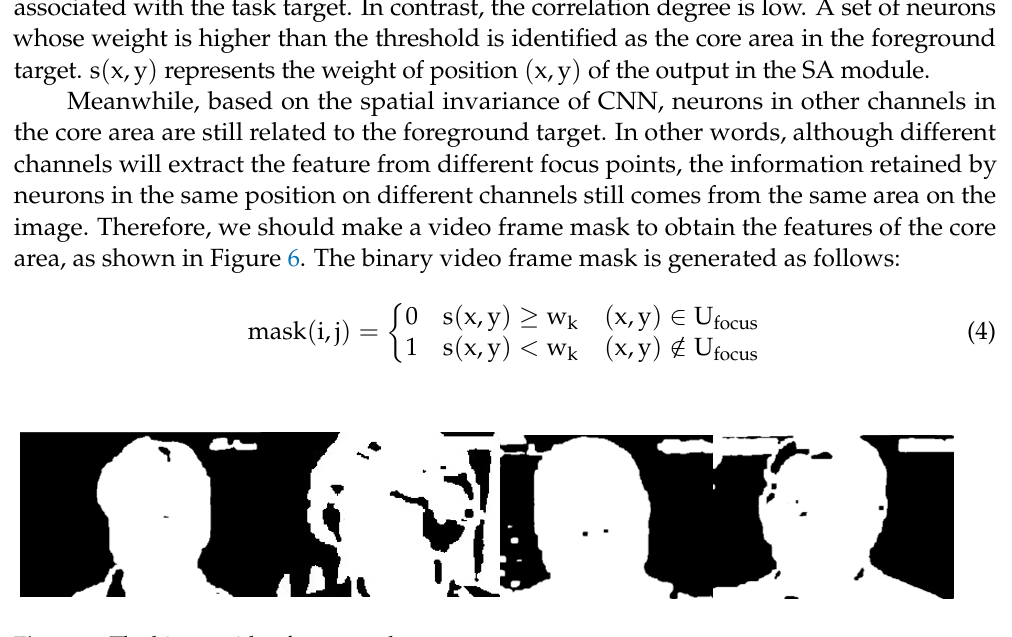
Figure 6. The binary video frame mask.